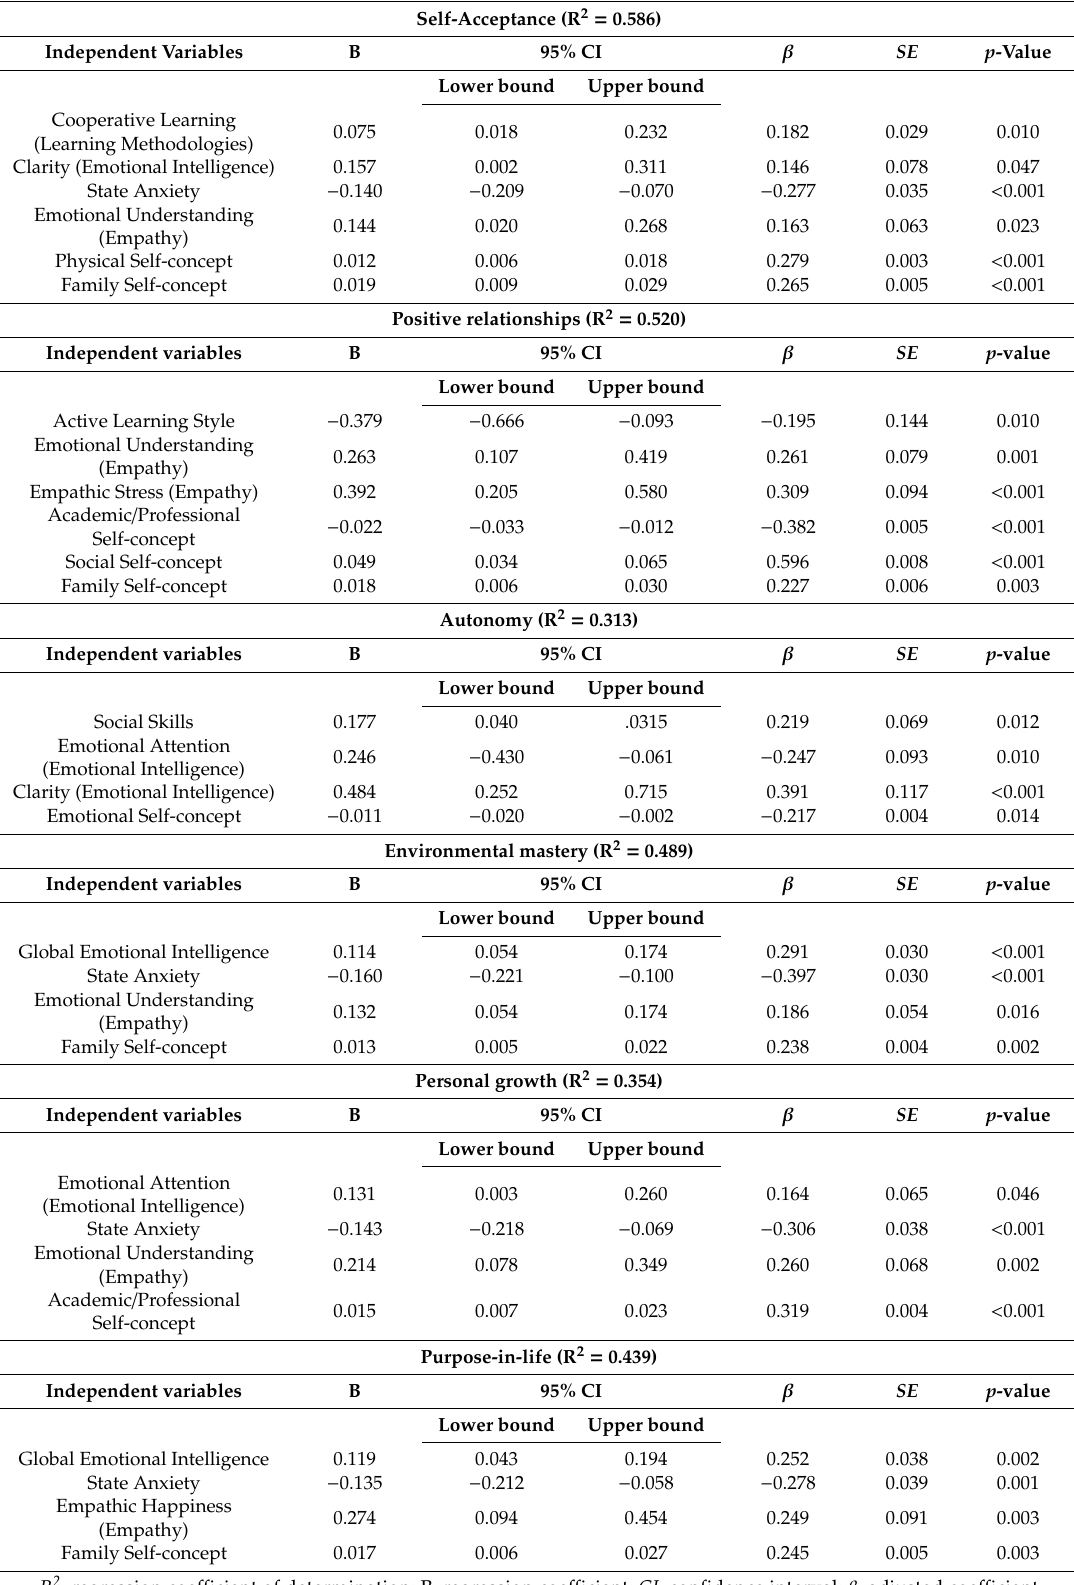
Table 3. Influence of psychosocial factors on psychological well-being in university students. Self-Acceptance (R 2 =